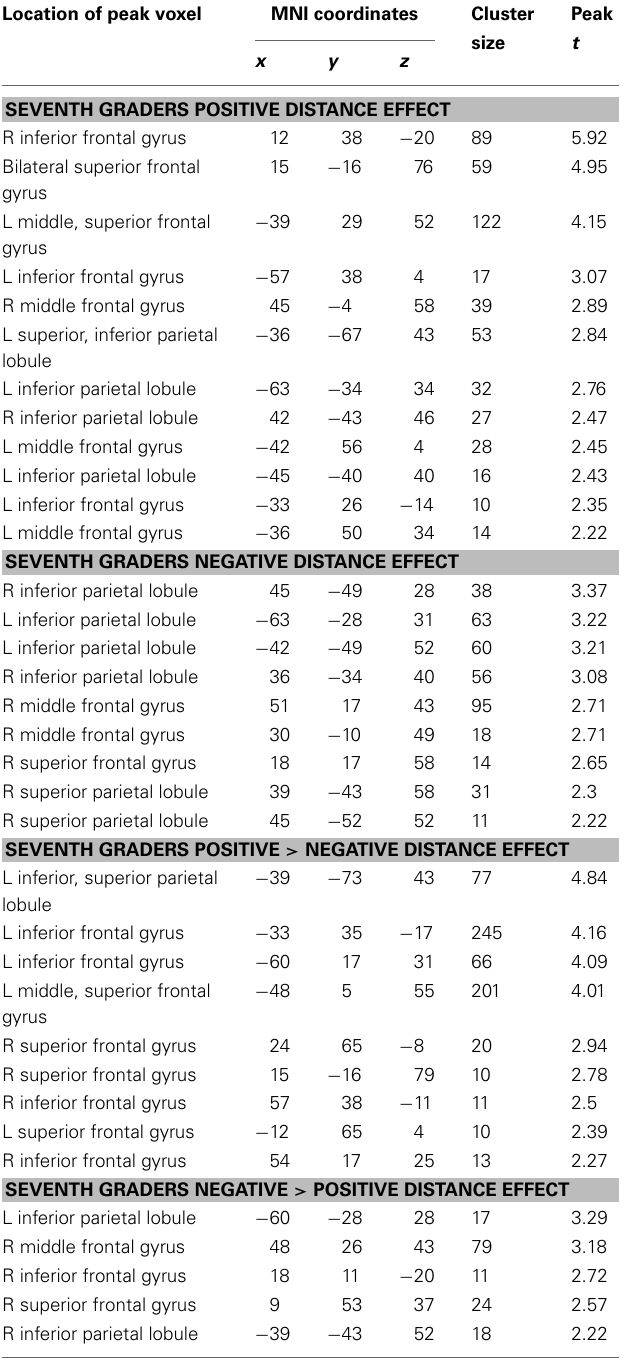
Table 5 | Seventh-grader neural distance effects for positive, negative comparisons.